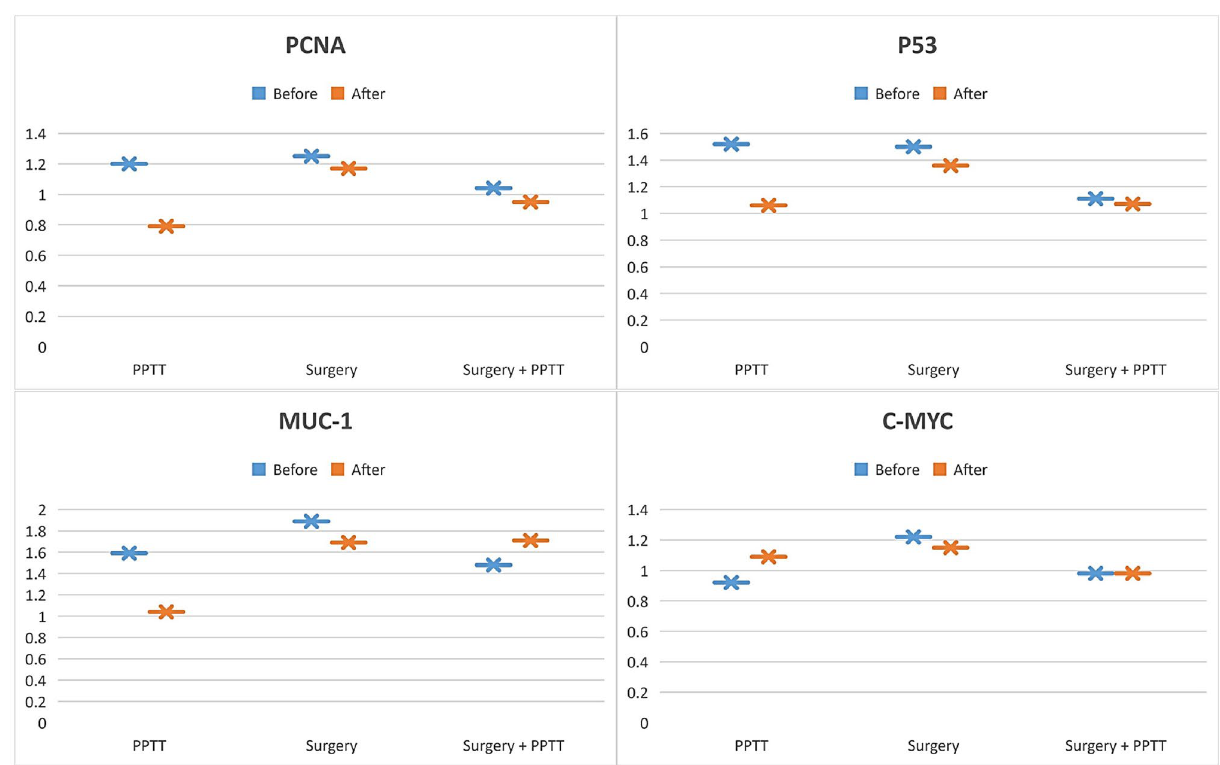
Figure 5. Comparison between AAbs values measured before treatment (first) and after treatment (last).